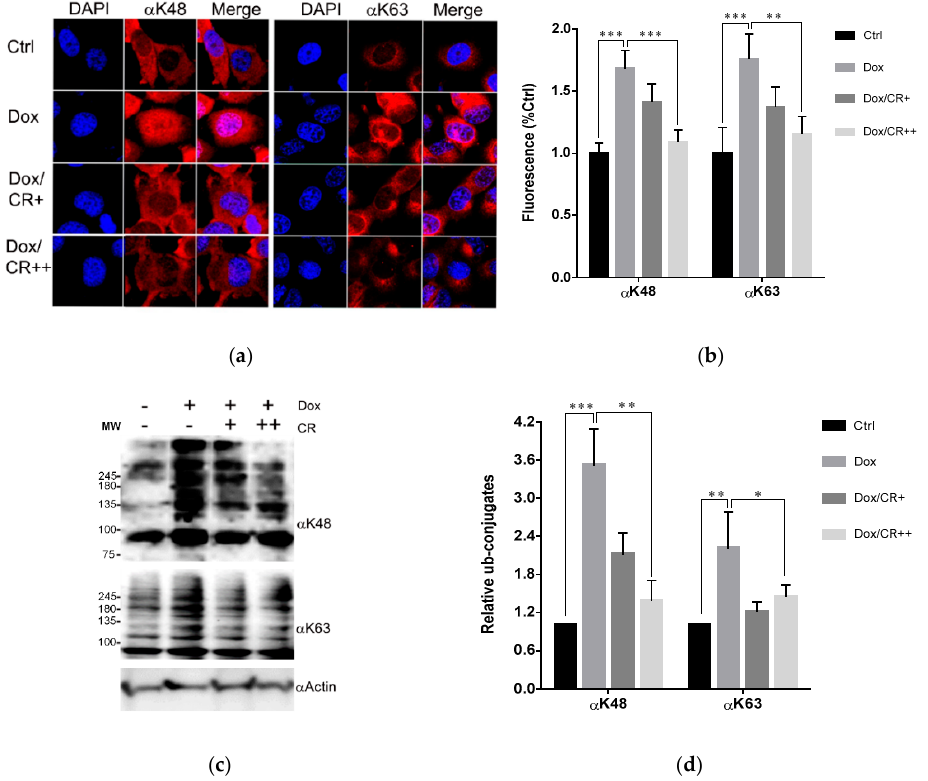
Figure 6. CR inhibits Dox-induced ubiquitination in the cells. ( a ) Immunofluorescence staining of H1299 cells treated with or without 5 (+) and 10 (++) µ M CR for 12 h followed by addition of Dox to a final concentration of 5 μ M, with incubation for 12 h. The cells were subjected to immunofluorescence staining using the antibodies against K48 ( α K48) and K63 polyubiquitins ( α K63). ( b ) K48 or K63 polyubiquitin level in Figure 6a was quantified by fluorescence signal. At least seven random regions acquired in confocal images were sampled and normalized against DAPI intensity for quantification. ( c ) Immunoblots of samples in Figure 6a using the indicated antibodies. ( d ) The band intensity of immunoblots in Figure 6c was quantified and displayed as the relative amount to the control. All error bars represent the standard deviation from at least four independent measurements. Statistical significance was calculated by the Student’s t -test (* p < 0.05, ** p < 0.01, *** p < 0.001)